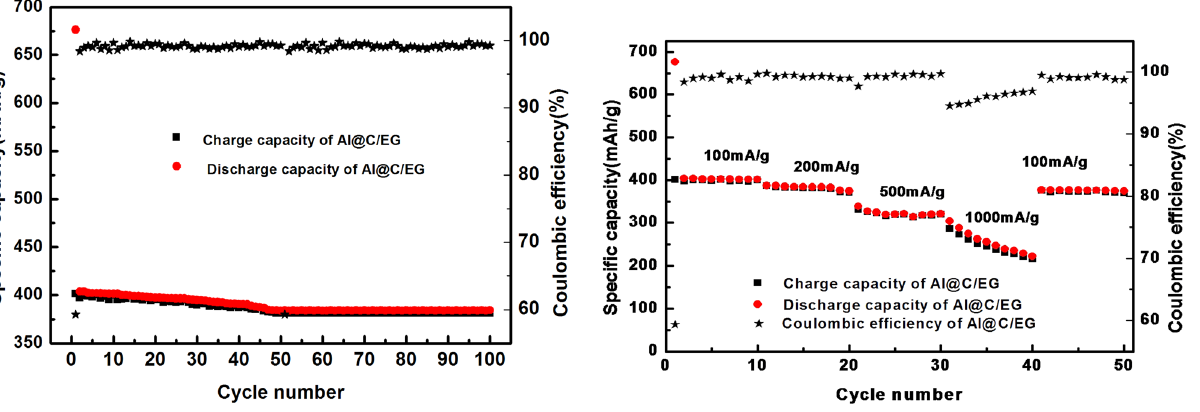
Figure 10: The charge – discharge performance of the C@Al – EG composite